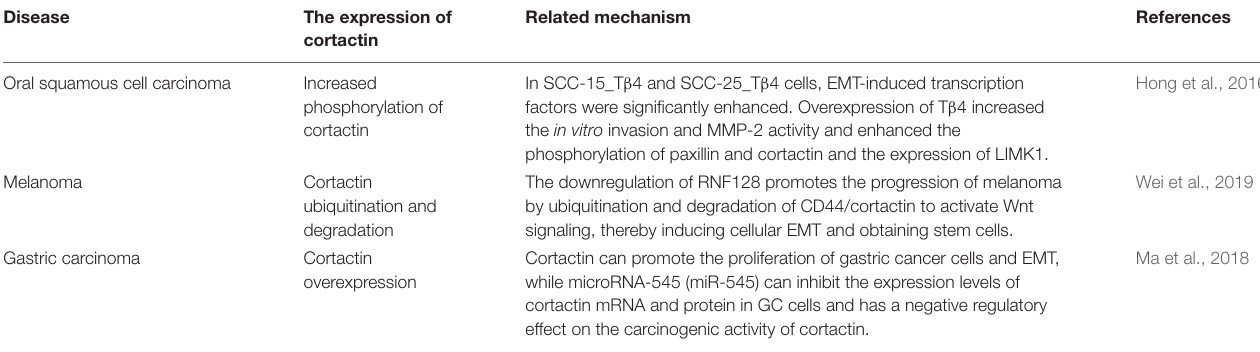
TABLE 2 | Cortactin induces EMT in other cancer syndromes and promotes the development of cancer syndromes.